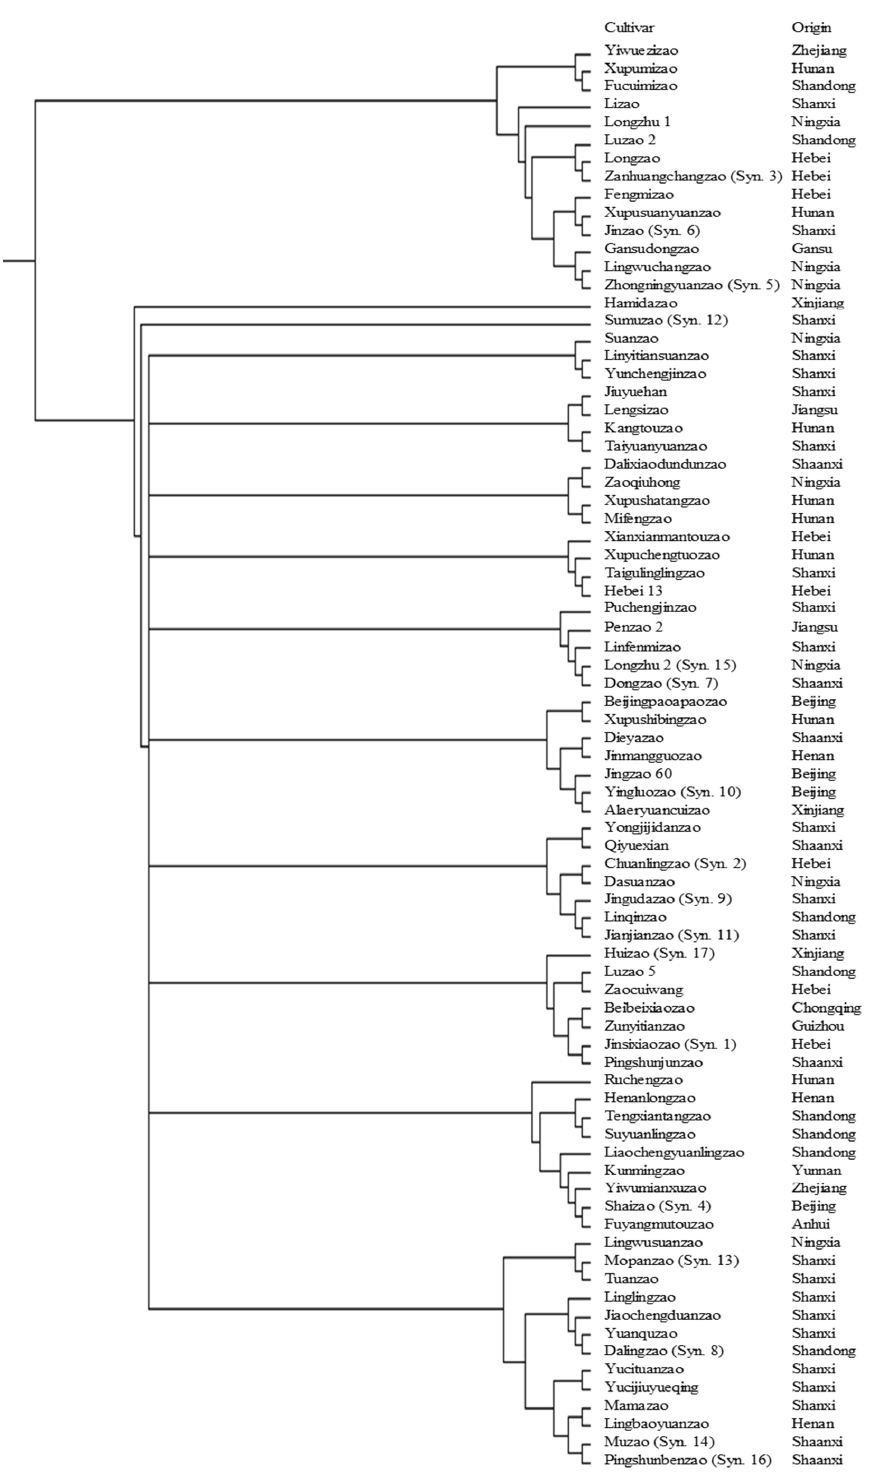
Figure 6. Neighbor-joining tree depicting the relationship among 79 jujube cultivars (and synonymous groups) from Ningxia jujube germplasm collection, Yinchuan, Ningxia. Identification of accessions corresponds to samples listed in Table 2.